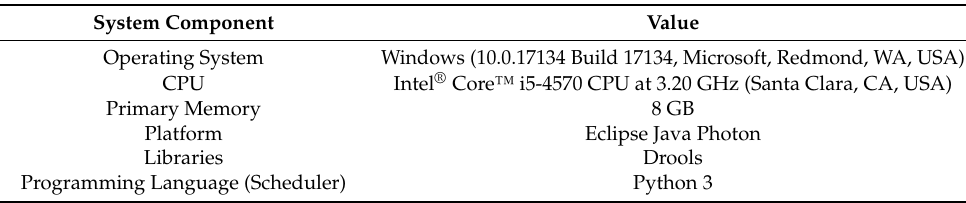
Table 5. Development environment.